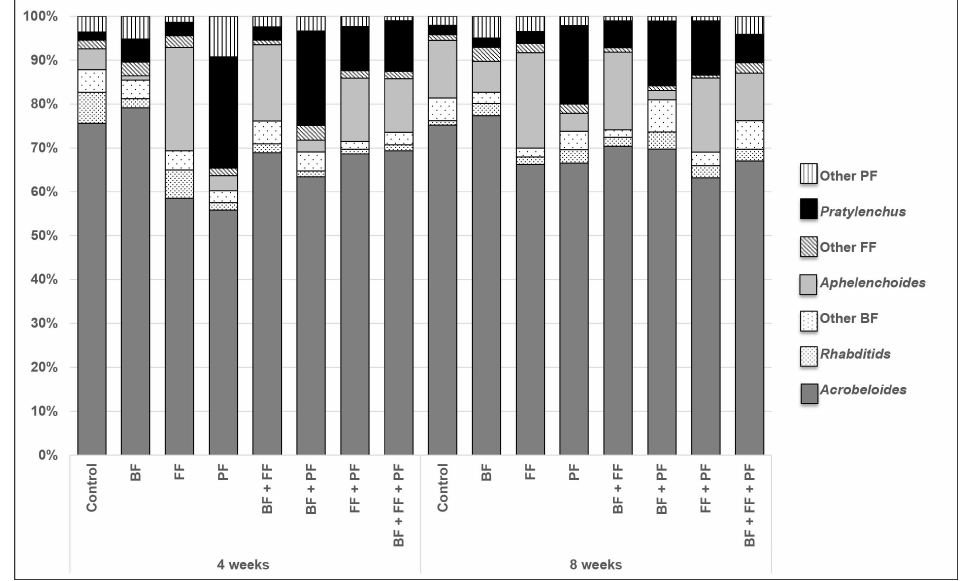
Figure 1. Nematode trophic structure (proportion in %) and dominant taxa at 4 and 8 weeks after nematode inoculation. Control—no nematodes inoculated, bacterial feeders—BF ( Acrobeloides buetschlii ), fungal feeders—FF ( Aphelenchoides saprophilus ), plant feeders—PF ( Pratylenchus penetrans